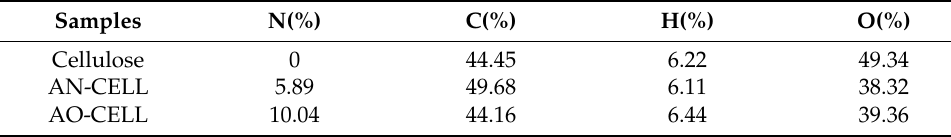
Table 1. Elemental analysis of cellulose and its derivatives.